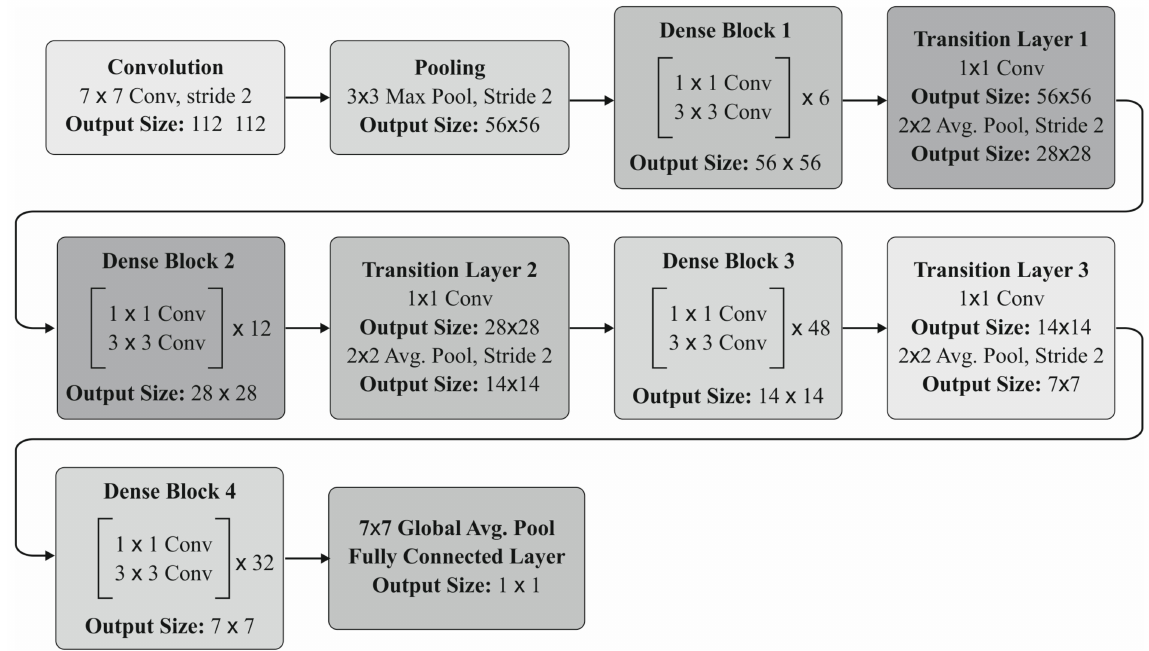
Figure 3. Layered architecture of